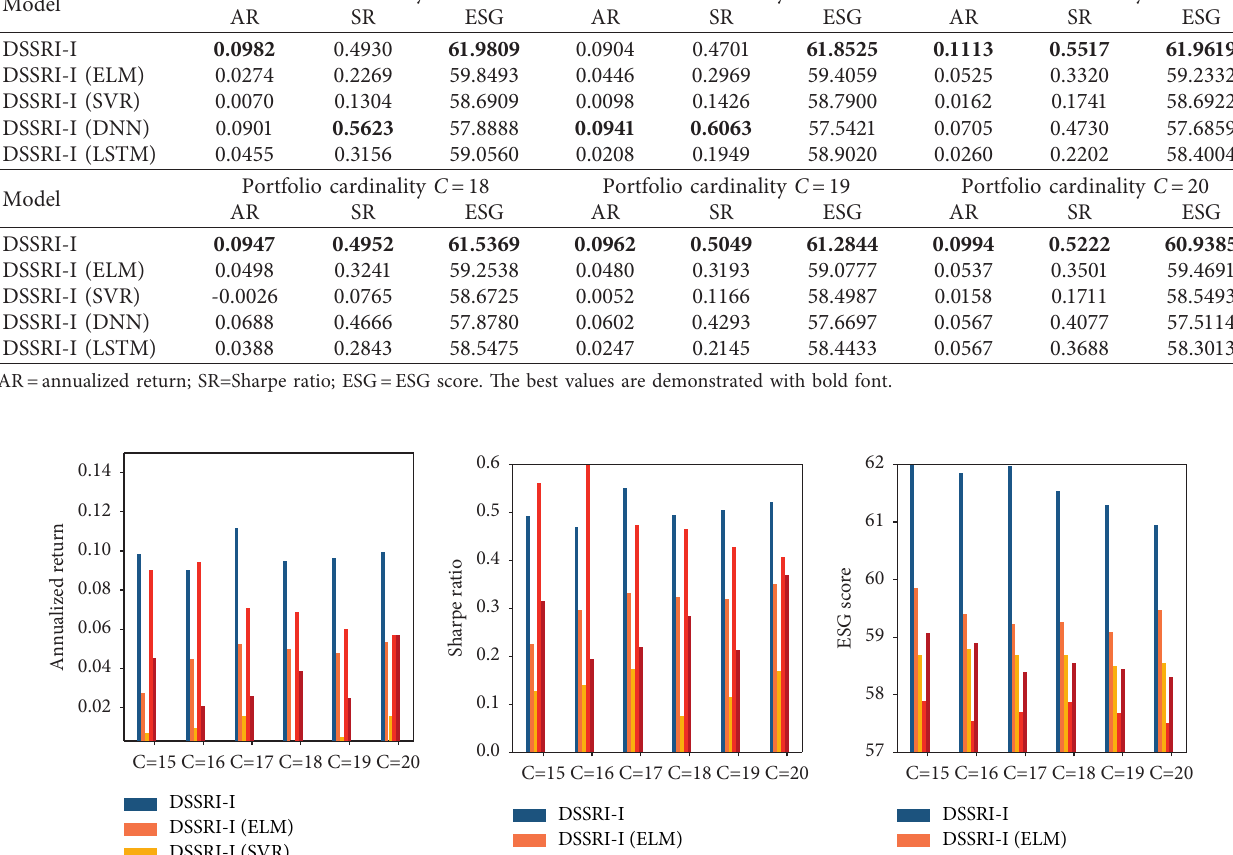
Table 6: Comparison of the DSSRI-I model and the DSSRI-I (based on other machine learning models).